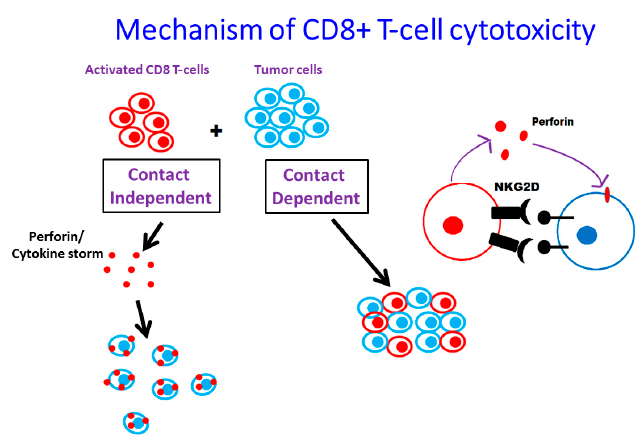
Figure 3. Contact dependent T-cell mediated tumor cell death. The T-cells activated following DNA vaccination were checked for antigen specific response. Our studies demonstrated that inflammatory release from Mam-A activated CD8+ T-cells is specifically upon contact with target tumor cell, and there by avoids a generalized cytokine storm response following